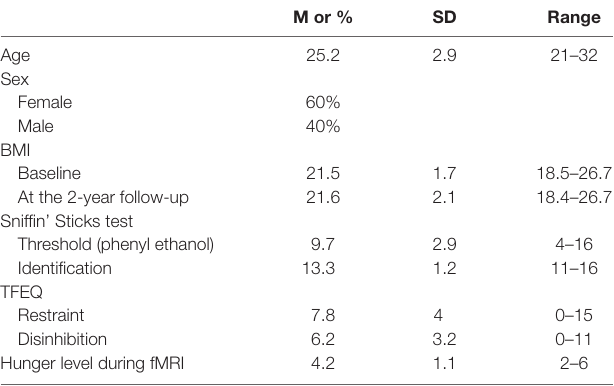
TABLE 1 | Study participant characteristics ( N =